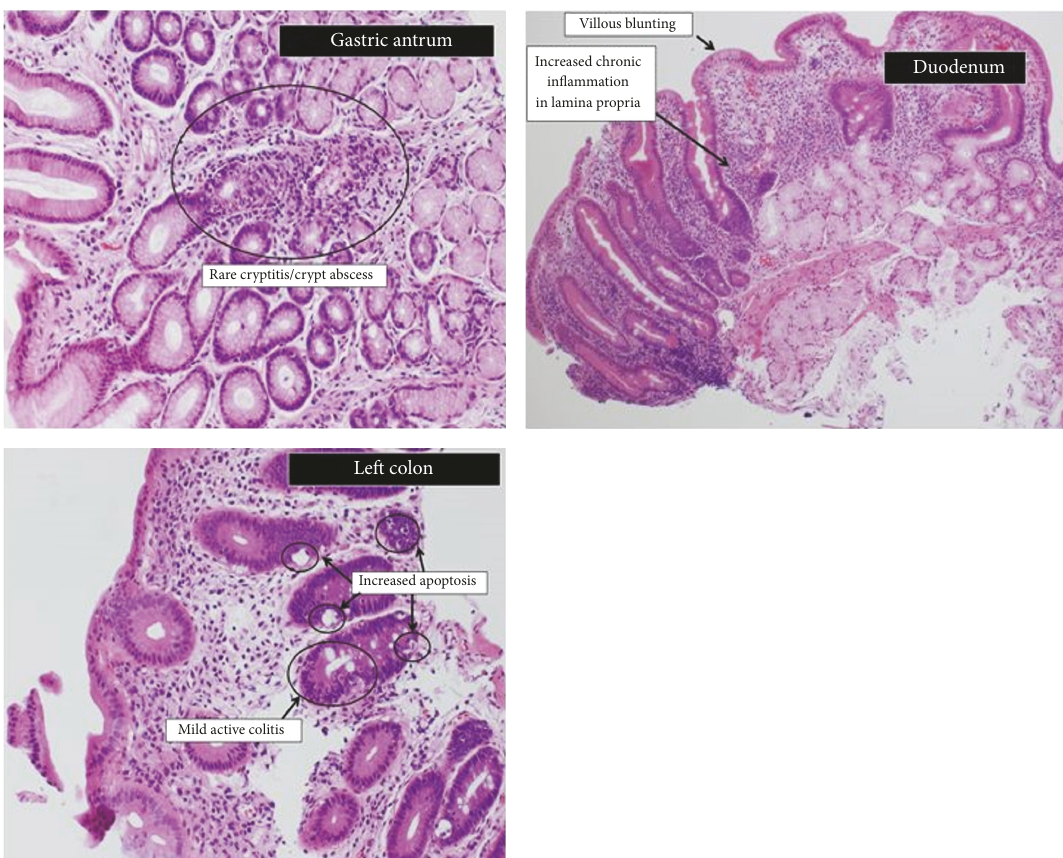
Figure 4: Overall acute inflammation and fewer architectural changes than that reported in this patient’s prior biopsy. The gastric biopsies showincreasedlaminapropriachronicinflammationwithonlyrarecryptswithcryptitisandcryptabscesses.Oxynticglandsareinabundance in the gastric body biopsies; The duodenum shows both goblet cells and Paneth cells and mild villous blunting, in contrast to the marked changes seen previously; The colon shows patchy active colitis, increased apoptosis, and marked loss of goblet